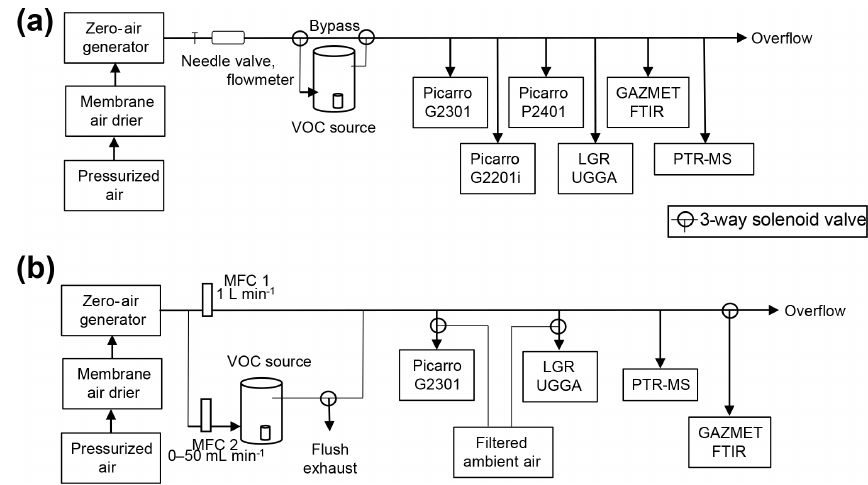
Figure 2. Schematic for air flow in laboratory tests 1 (a) and 2 (b) .